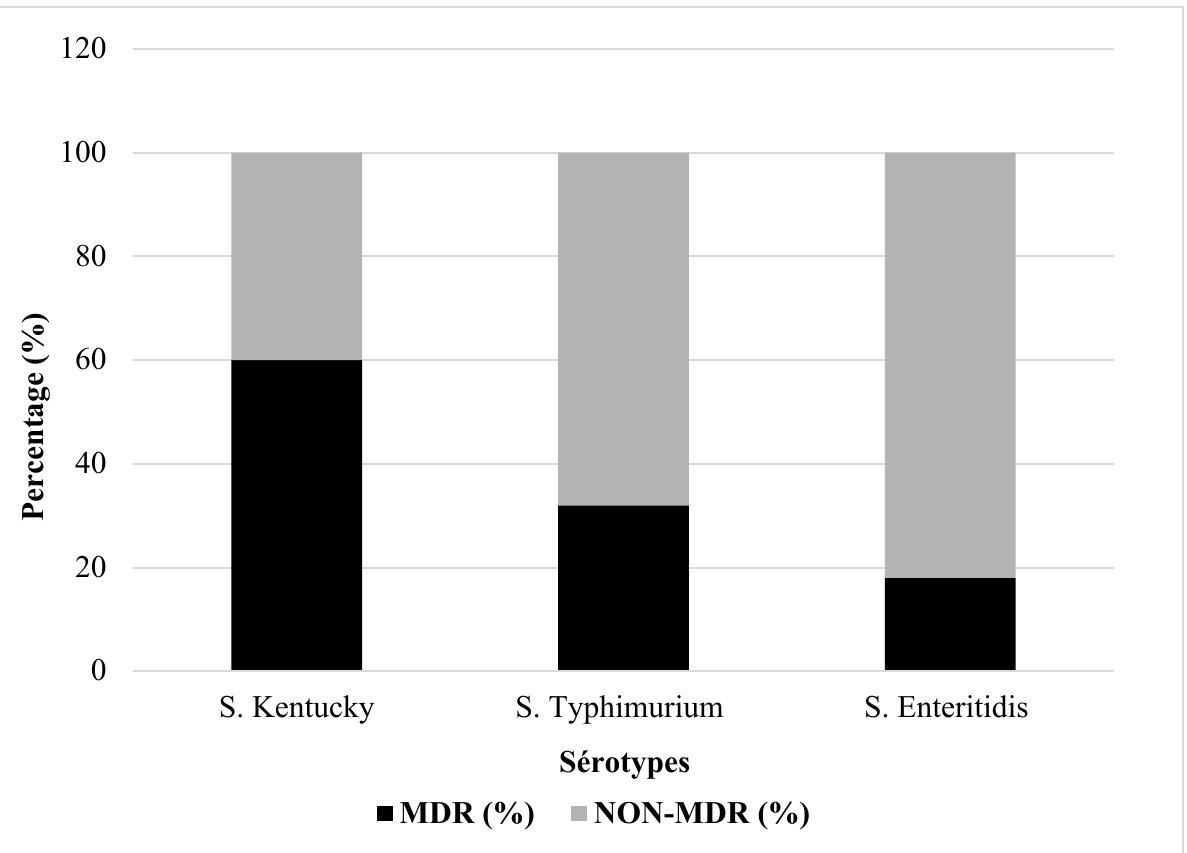
Figure 2. Proportion of MDR Salmonella strains according to predominant serotypes.